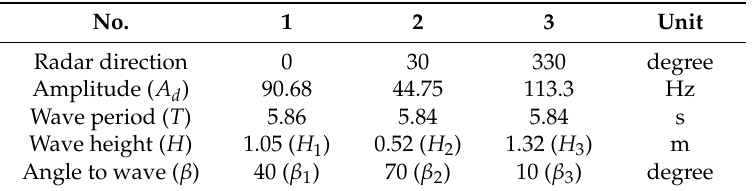
Table 4. Three simulation results.